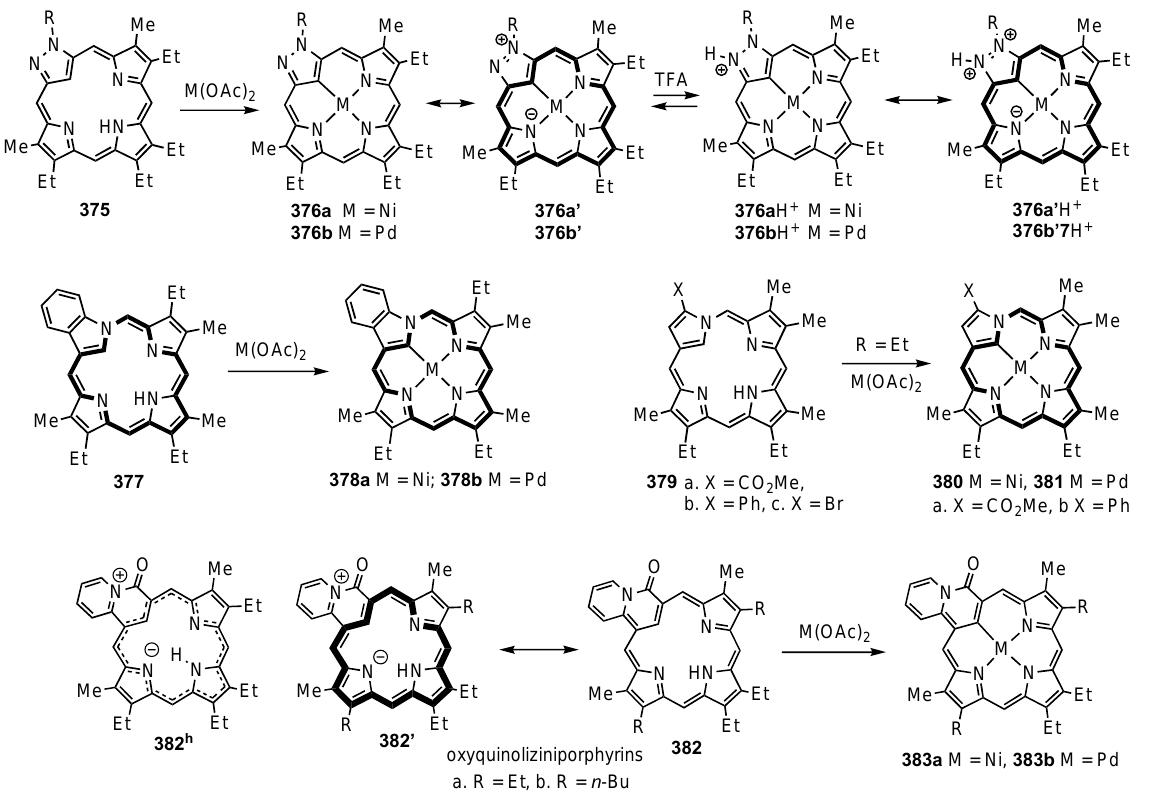
Scheme 62. Metal complexes of pyrazoloporphyrins, neo-confused porphyrins and oxyquinoliziniporphyrins.